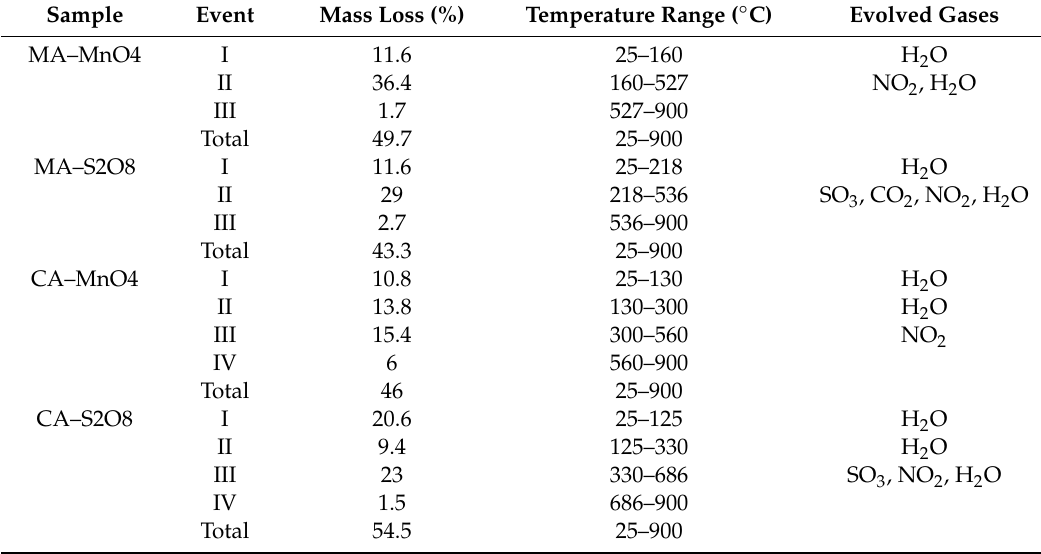
Table 3. Summary of the thermal decomposition data for all of the samples